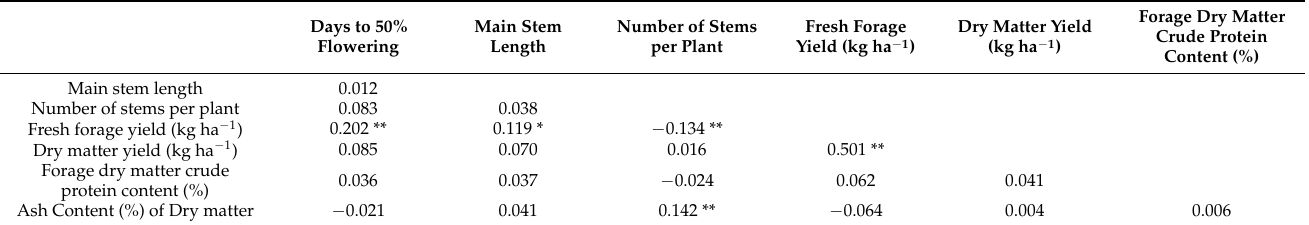
Table 5. Correlations between all traits measured: days to 50% flowering, main stem length, a number of main stems per plant, fresh forage yield (kg ha − 1 ), dry matter yield (kg ha − 1 ), forage dry matter crude protein content (%), and ash content (%) of dry matter.